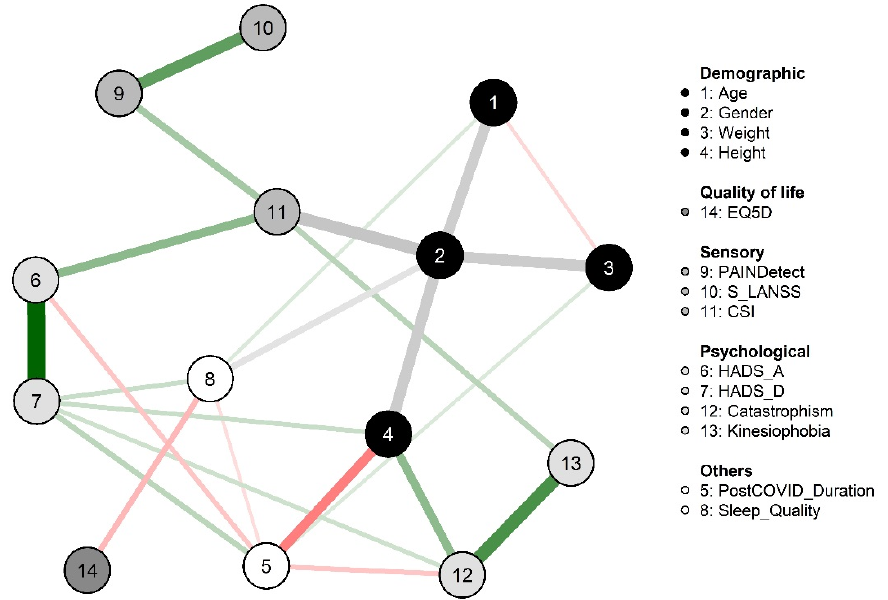
Figure 1 graphs the network in the sample of COVID ‐ 19 survivors with post ‐ COVID pain. Different associations between sensory ‐ related and psychological/cognitive varia ‐ bles were observed. PainDETECT was associated with S ‐ LANSS ( 𝜌 : 0.388) and CSI ( 𝜌 : 0.207). In addition, CSI was associated with HADS ‐ A ( 𝜌 : 0.269), TSK ‐ 11 ( 𝜌 : 0.165) and fe ‐ male sex ( 𝜌 : 0.413). As expected, HADS ‐ A was associated with HADS ‐ D ( 𝜌 : 0.598) and TSK ‐ 11 with PCS ( 𝜌 : 0.405). The only negative association was between sleep quality and EQ ‐ 5D ‐ 5L ( 𝜌 : − 0.162).